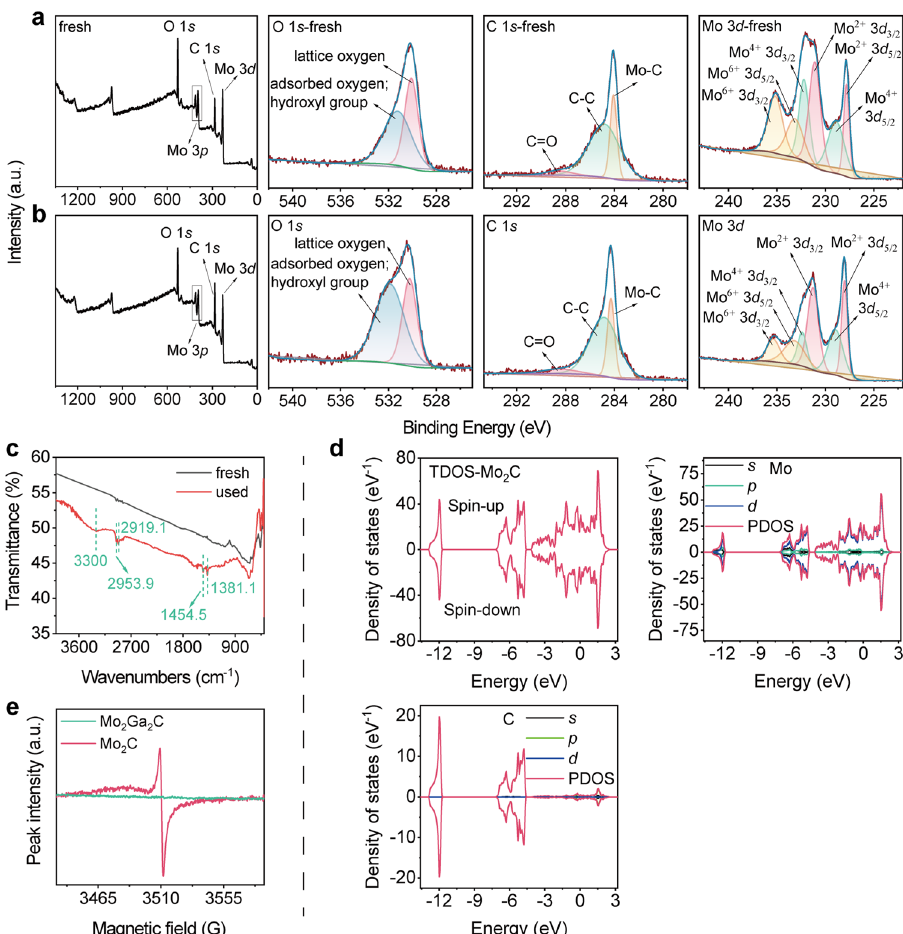
Fig. 4 Analysis of Mo-de fi cit vacancy defects. X-ray photoelectron spectroscopy (XPS) of the a fresh and b used Mo 2 C MXene. c Fourier Transform Infrared (FTIR) spectrum for fresh and used Mo 2 C MXene. d The total density of states (TDOS) and partial density of states (PDOS) of Mo 2 C MXene based on density functional theory (DFT) calculation. e Electron paramagnetic resonance (EPR) of Mo 2 Ga 2 C and fresh bond on Mo 2 C MXene surface 26 . The O 1 s spectrum was deconvoluted into two peaks (530.09 and 531.23 eV); they were contributed by the surface lattice oxygen in the metal – oxygen bond and adsorbed oxygen and the hydroxyl group, respec- tively 7,57 . The content of the adsorbed oxygen and the hydroxyl group increased from 54.96% to 64.20% after the reaction of Mo 2 C MXene. The results indicate that the Mo 2 C MXene surface would adsorb some oxygen-containing groups during the reaction. The high-resolution spectrum of Mo 3 d XPS was deconvoluted into six peaks. The Mo 3 d 5/2 peak positions located at 227.83, 228.90, and 233.14 eV, were Mo 2 + , Mo 4 + , and Mo 6 + , respectively, and the corresponding Mo 3 d 3/2 peak positions appear at 231.09, 232.21, and 235.19 eV 63 . Among them, Mo 4 + and Mo 6 + may be generated